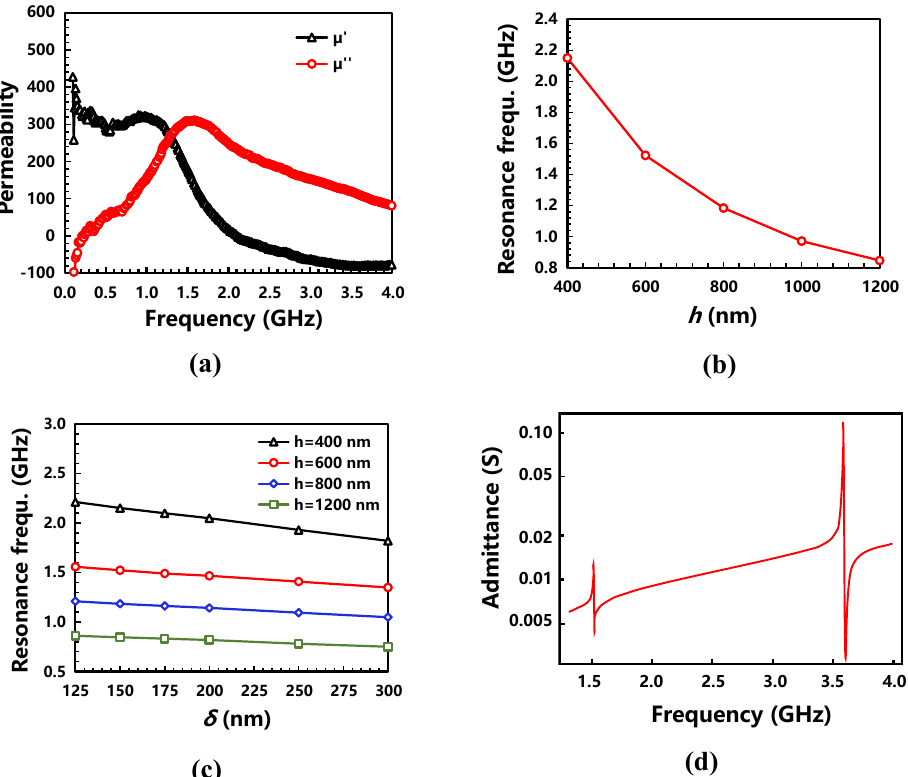
Figure 6. Design of the magnetic sensor by resonance enhanced ME coupling: ( a ) permeability of the FeGaB/Al 2 O 3 composite by ESR and the FMR matching by changing the thickness of ( b ) the piezomagnetic/piezoelectric heterostructure and ( c ) the electrode; ( d ) after matching the frequency, the admittance curve of the two-layer device was obtained by applying an AC voltage to the piezoelectric layer of the ME heterostructure without a bias magnetic field.